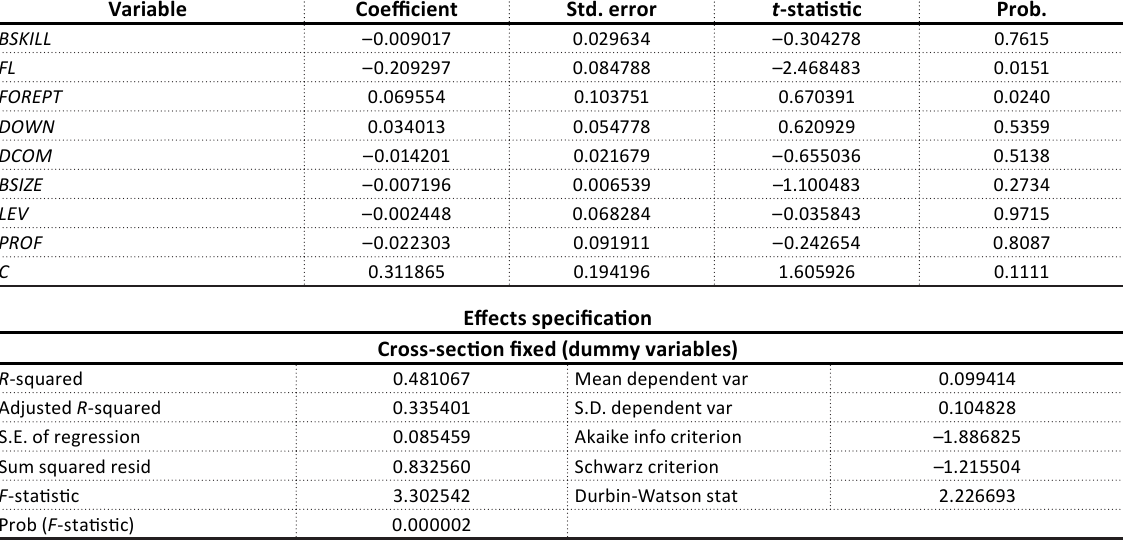
Table 5. Panel regression analysis